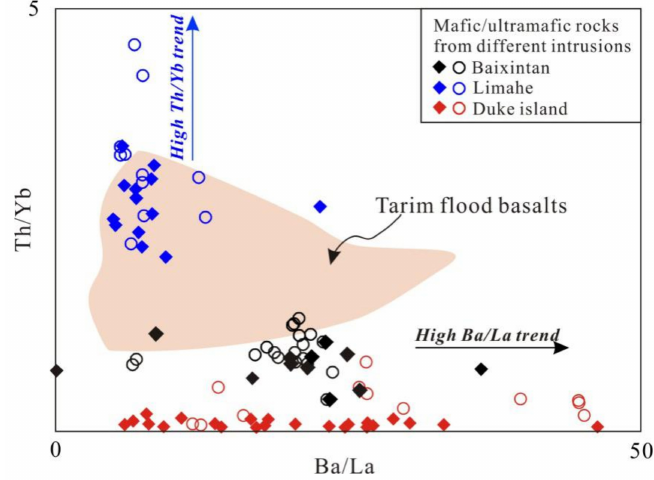
Figure 14. Ba/La-Th/Yb diagram (after [126]). Data sources of Baixintan: this paper, [84]; data sources of Limahe: [80,81]; data source of Duke Island: [115]; data sources of the Tarim flood basalts field (51 samples):